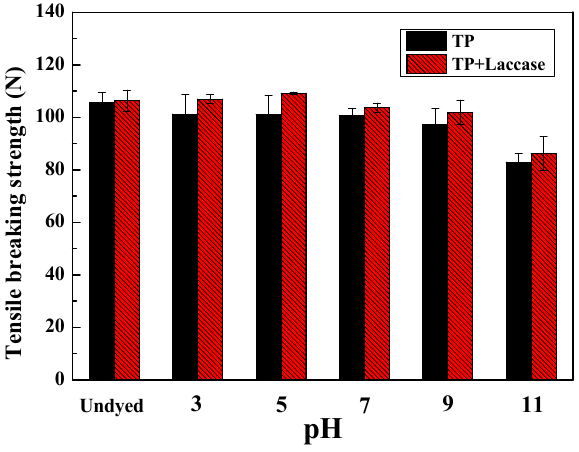
Figure 6. Effect of pH value on breaking strength of dyed silk fabrics.